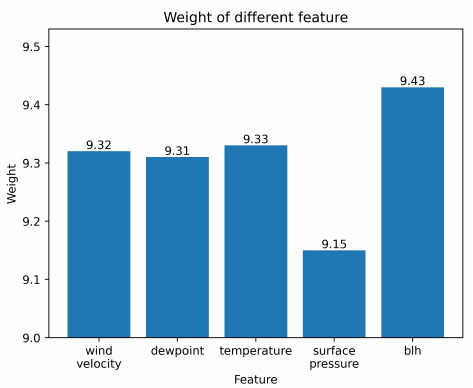
Figure 9. Importance of different features in the